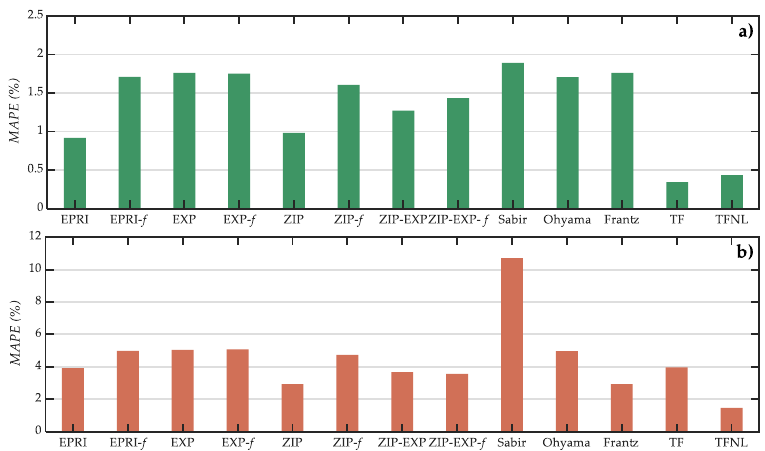
Figure 16. Average of mean absolute percentage error (MAPE) index using multiple responses; ( a ) real and ( b ) reactive power.